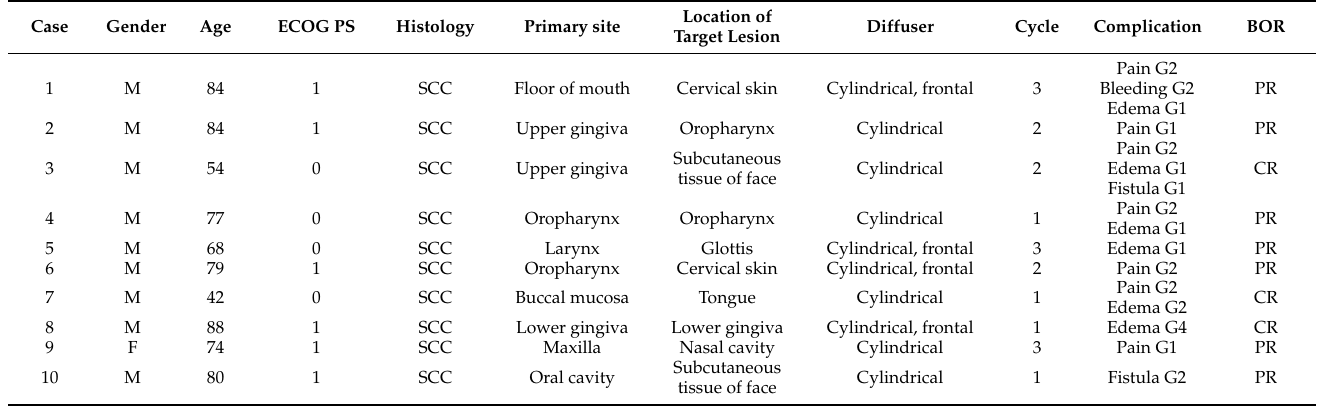
Table 1. Characteristics of patients treated with